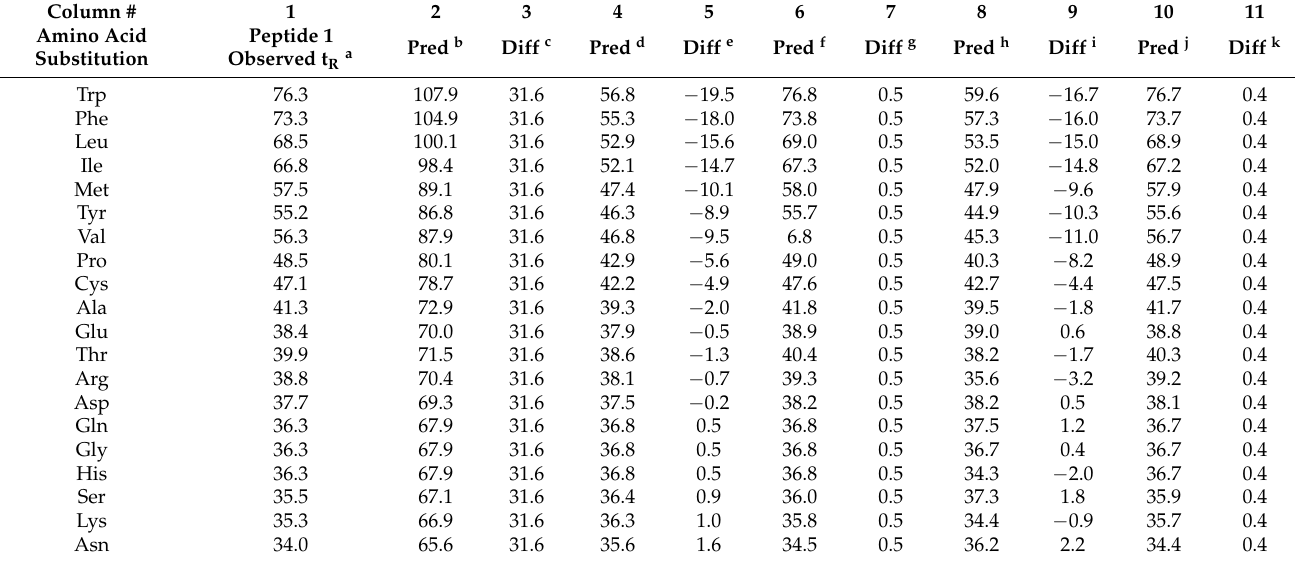
a from Table 13; b by applying the retention coefficient estimated at C -terminal for all amino acids; c difference between the predicted 2 and the observed 1; d by applying the weighed retention coefficients estimated at C -terminal for all amino acids including at C -terminus position; e difference between the predicted 4 and the observed 1; f by applying the weighed retention coefficients estimated at C -terminal for all amino acids except at C - terminus position; g difference between the predicted 6 and the observed 1; h by applying the internal coefficients for all amino acids including at C -terminus position; i difference between the predicted 8 and the observed 1; j by applying a combination of the internal coefficients and C -terminus ones accordingly; k difference between the predicted 8 and the observed 1. Mobile phase A: 20 mM TFA in water (containing 2% v / v of acetonitrile); mobile phase B: 0.2% TFA in acetonitrile. Column: Kromasil C 18 , 5 µ m, 2.1 × 150 mm. Pred: predicted retention time; Diff: Difference between the predicted and observed retention time. All data are in